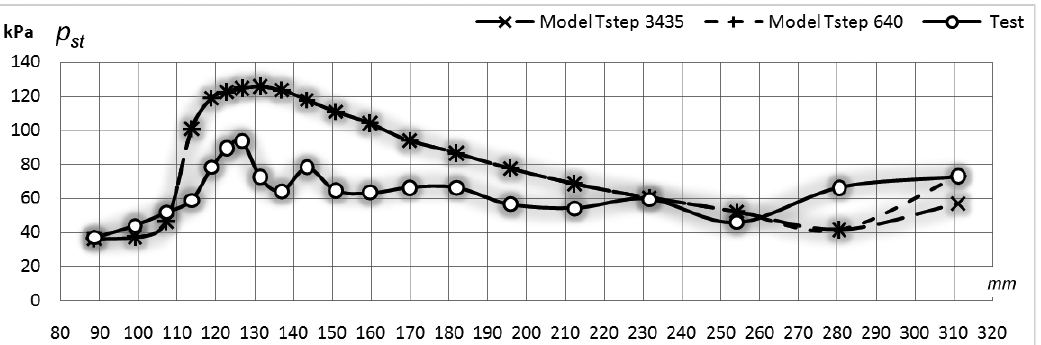
Figure 12. Static pressure distribution on the inlet diffuser’ side surface (at the points of drainage according to Figure